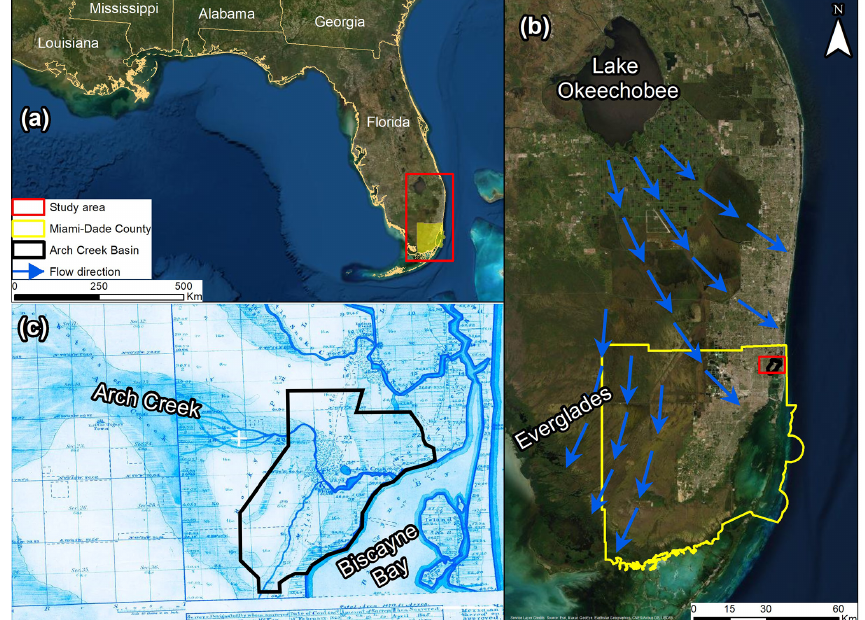
Figure 1. Location map of the study area. (a) MDC located in southeast Florida, USA, (b) current Everglades water flow from Lake Okeechobee towards the Atlantic Coast and Gulf of Mexico, and (c) land survey from 1870 that illustrates the natural flow direction of Arch Creek to its discharge into Biscayne Bay prior to urbanization (Miami Herald,